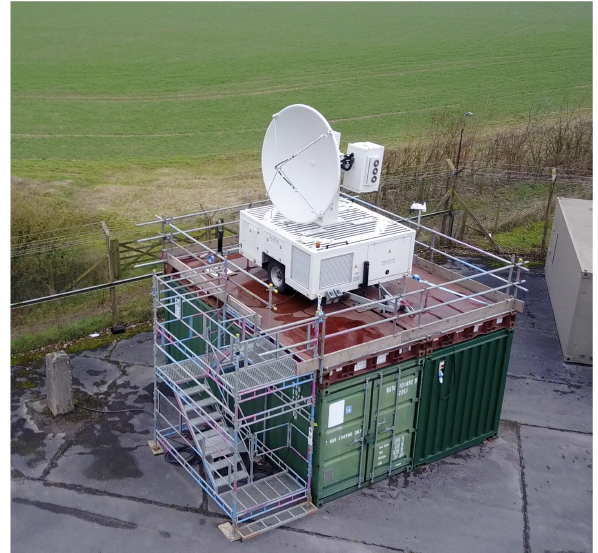
Figure 3. NXPol deployed at Chilbolton Observatory, Hampshire, UK. Seen in the picture is the 20 (cid:48) (6.058m) shipping container, 20 (cid:48) office container, two 20 (cid:48) platform containers and scaffolding used to construct a platform for the